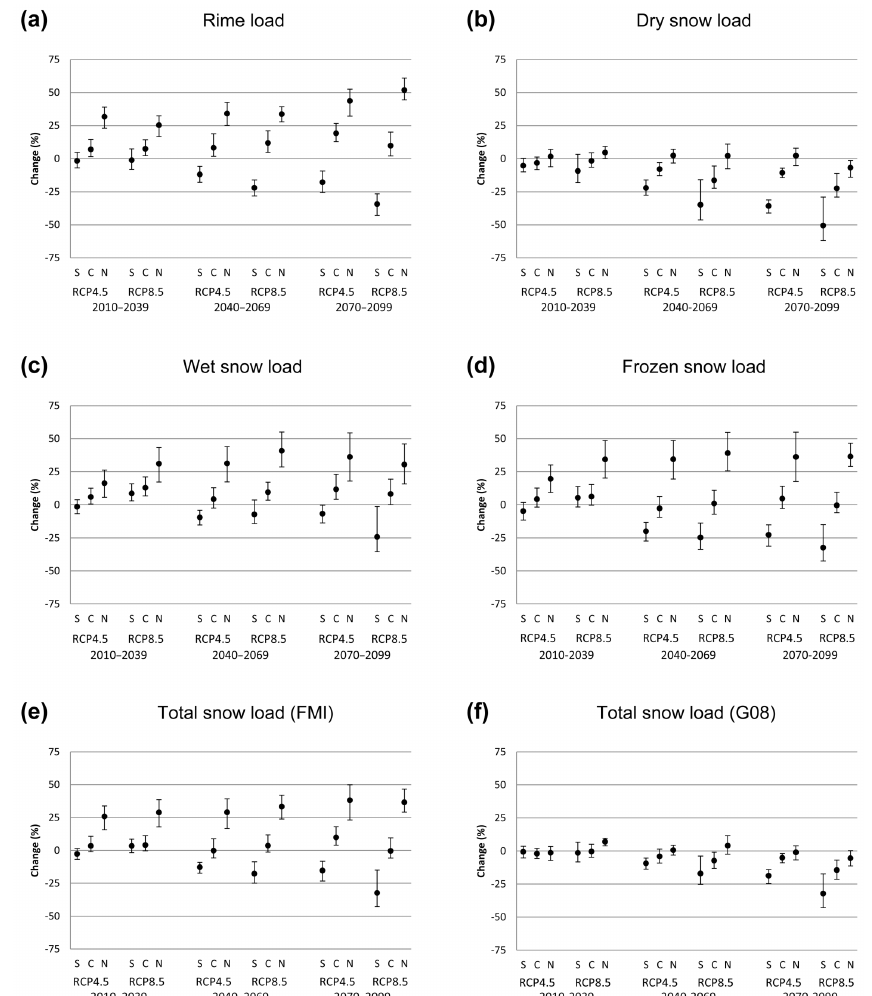
Figure 6. Projected changes in the annual maximum rime loads (a) , dry snow loads (b) , wet snow loads (c) , frozen snow loads (d) , total snow loads based on the FMI method (e) and total snow loads based on the G08 method (f) compared to the period 1980–2009 and averaged over southern (S), central (C) and northern (N) Finland. Dots indicate the multi-model mean change and whiskers extend to the maximum and minimum